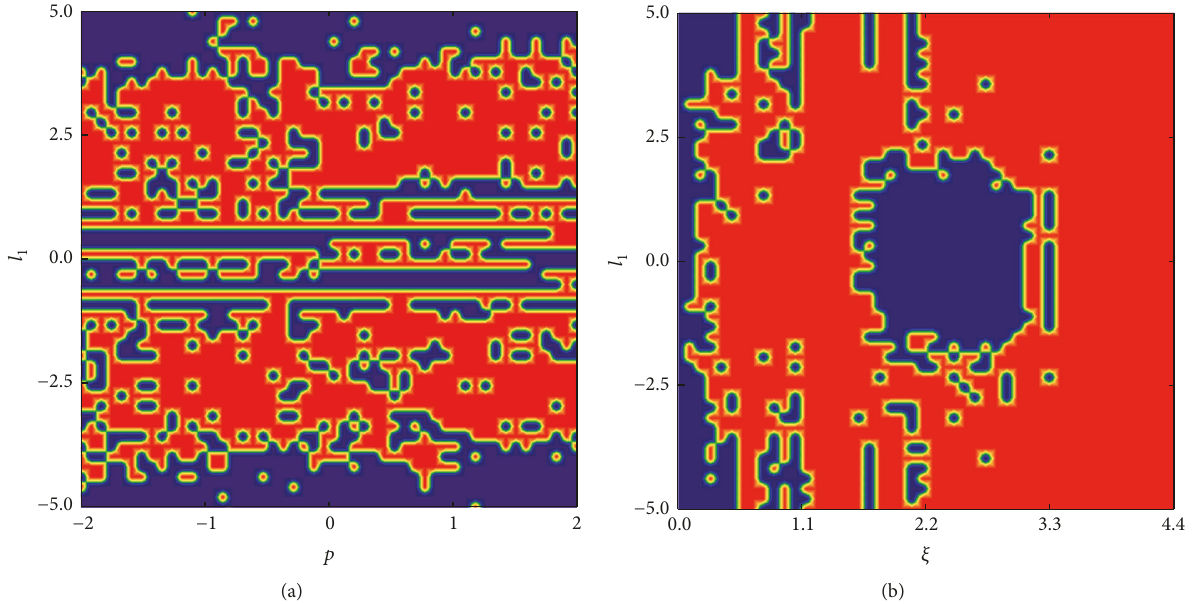
Figure 6: Attraction basins: (a) under initial conditions (0.1, 0.1,𝑝, 𝑙 1 ) and (b) under initial condition 𝑙 1 and system parameter 𝜉